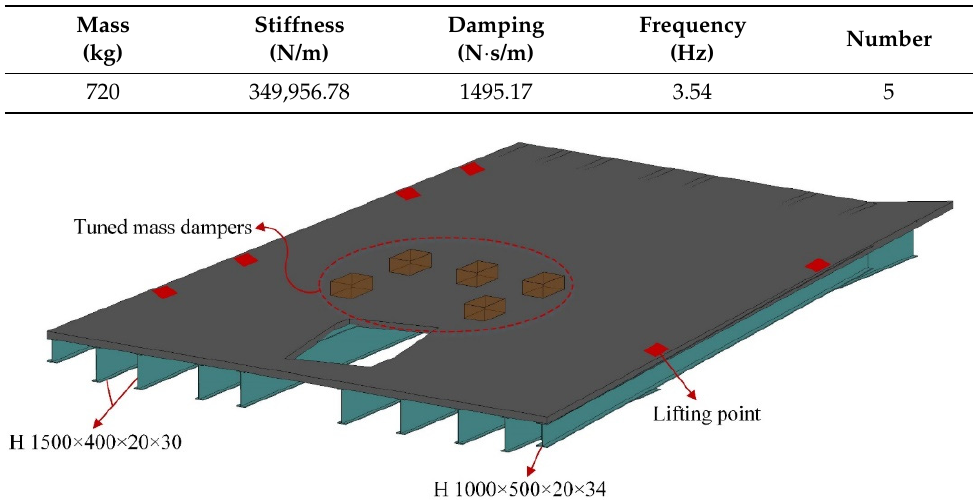
Figure 15. Installation locations of TMDs on the suspended floor.